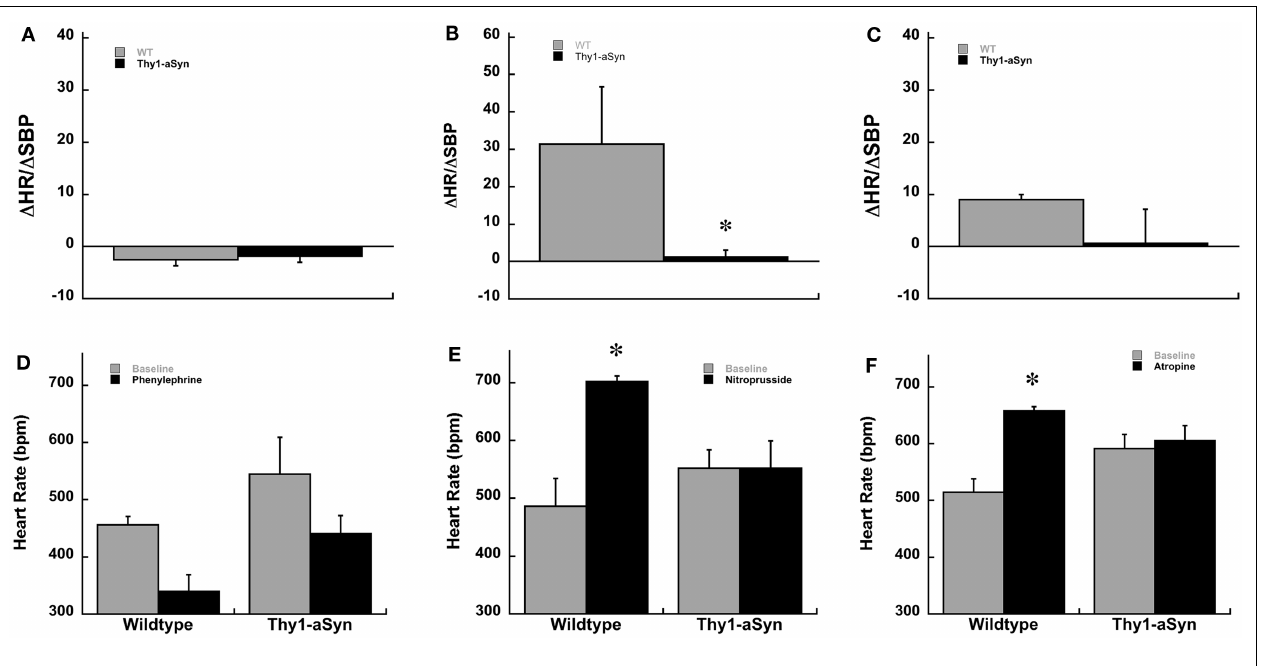
sodium nitroprusside (E) , and atropine (F) . *Represents p < 0.05 compared to WT, ∆ represents p < 0.05 compared to baseline (0.0mg/kg) within same genotype (Mann–Whitney U and mixed design ANOVA followed by Fisher’s